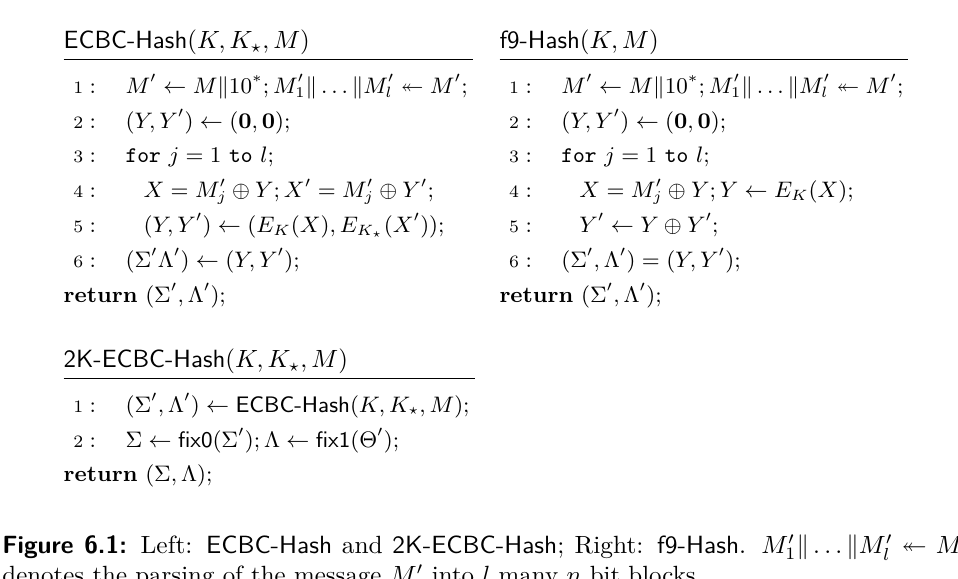
Figure 6.1: Left: ECBC-Hash and 2K-ECBC-Hash ; Right: f9-Hash . M 0 denotes the parsing of the message M 0 into l many n bit